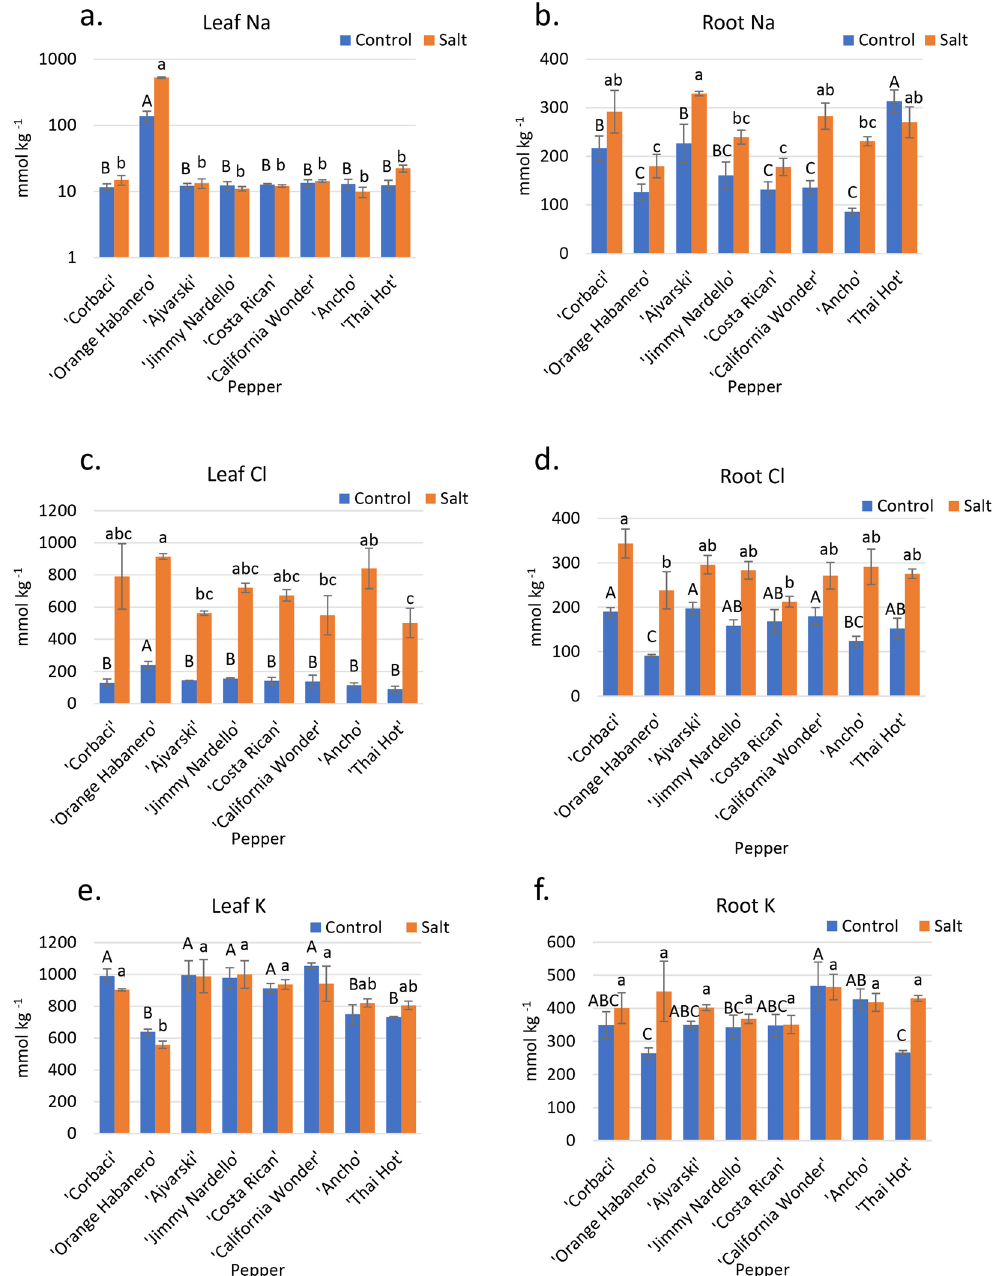
Figure 4. Tissue ion concentrations of eight pepper cultivars irrigated with control and saline irrigation waters. ( a ) Leaf Na concentrations. ( b ) Root Na concentrations. ( c ) Leaf Cl concentrations. ( d ) Root Cl concentrations. ( e ) Leaf K concentrations. ( f ) Root K concentrations. Capital letters denote differences among cultivars under control conditions, while lowercase letters denote significant differences under saline conditions ( p < 0.05). Error bars represent standard